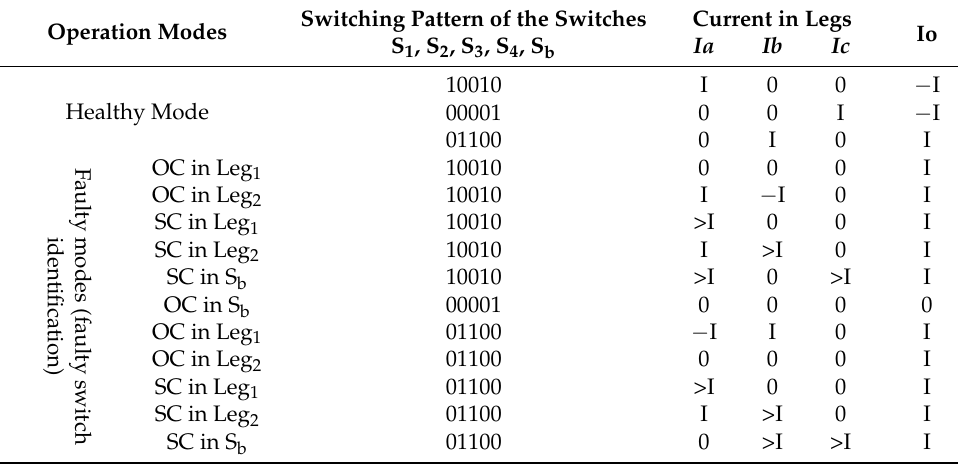
Figure 7. Fault diagnosing and reconfiguration flowchart. Table 1. Operation modes of the proposed fault tolerant inverter.